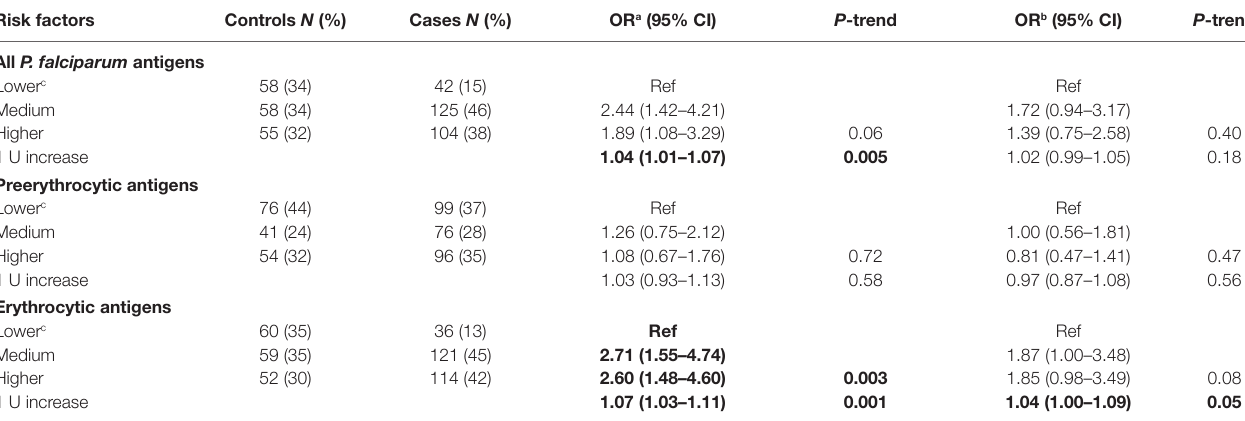
TaBle 2 | ORs of endemic Burkitt lymphoma for the burden of IgGs to Plasmodium falciparum antigens.